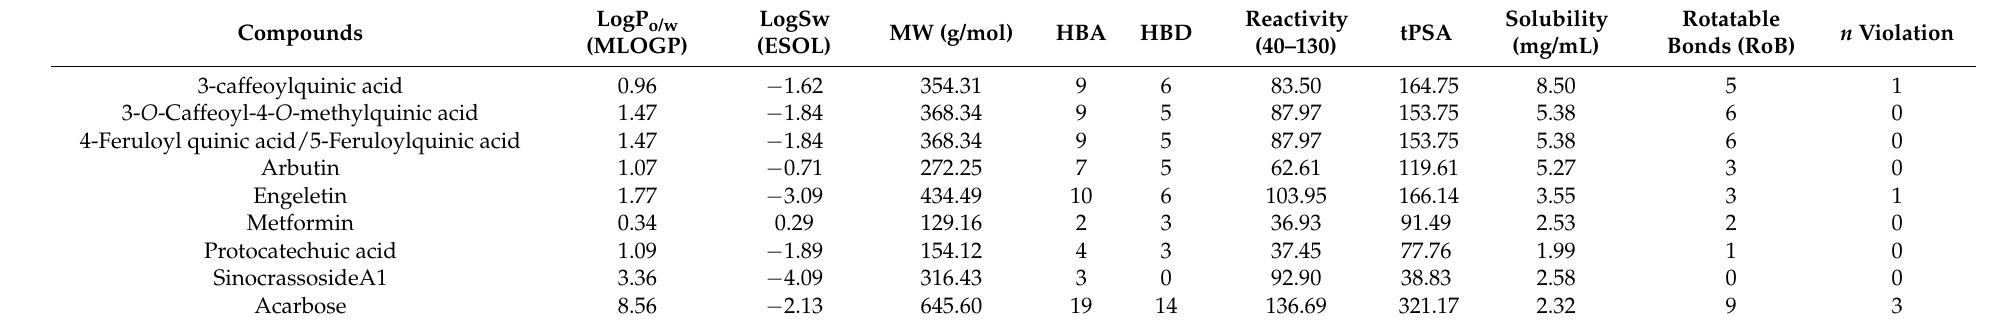
Table 2. Predicted pharmacokinetic parameters (ADME properties) of the compounds selected from plant LC-MS analysis.